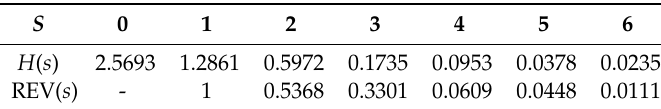
Table 1. Computational results.